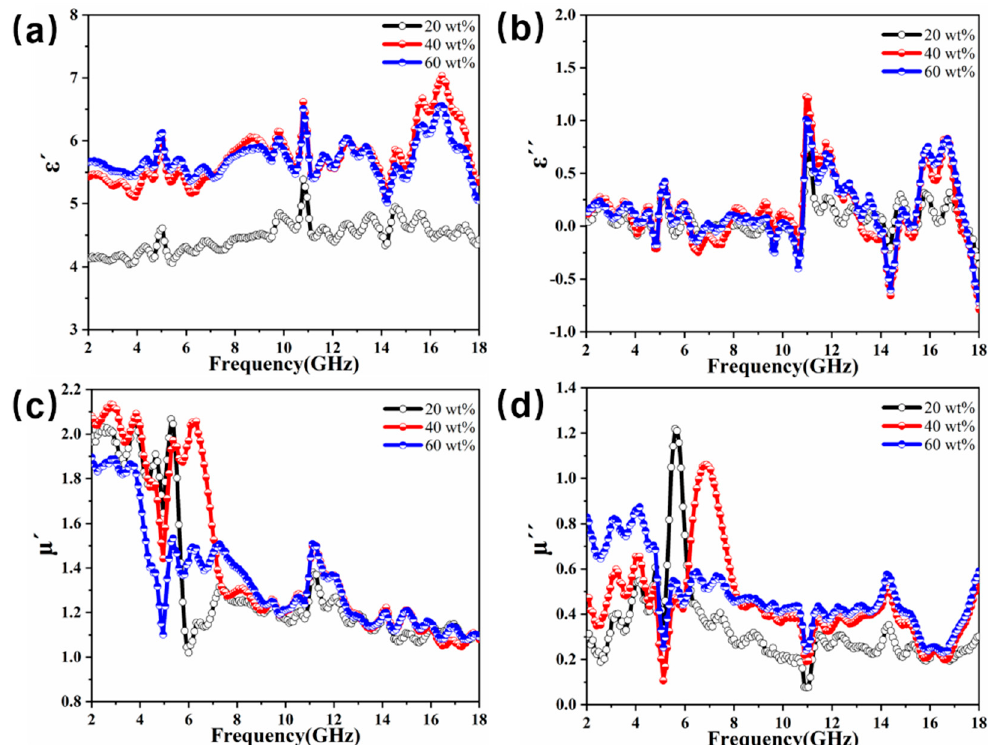
Figure 6. Frequency dependence of ( a ) real and ( b ) imaginary parts of complex permittivity, ( c ) real part, and ( d ) imaginary part of the relative complex permeability of the CIP@MnO 2 composites with different filling ratios.